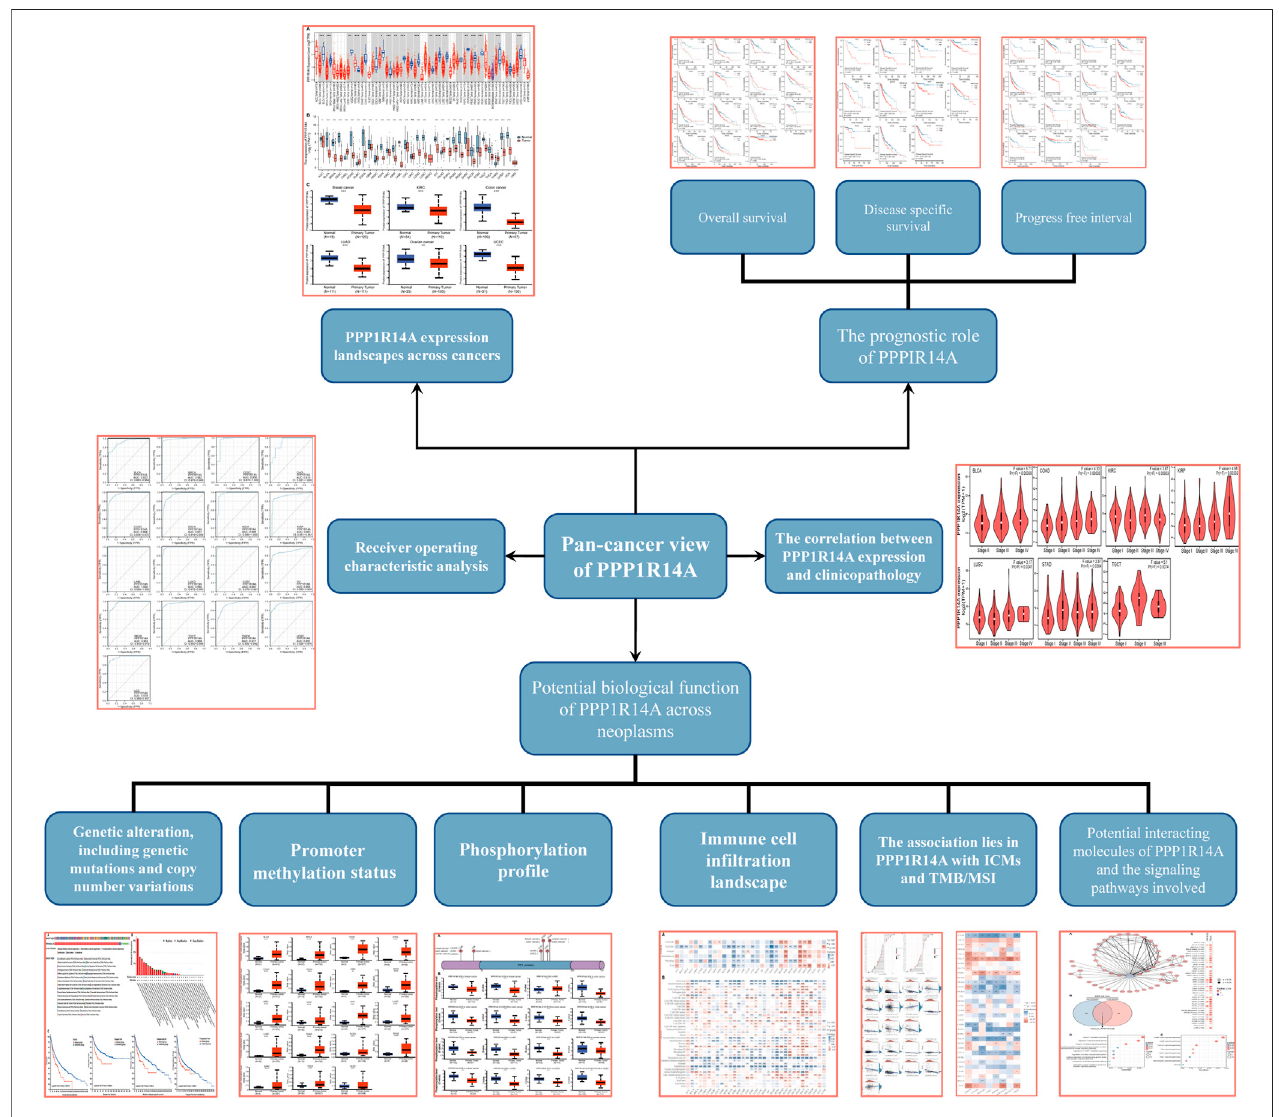
FIGURE 2 | Schematic representation of the key fi ndings in the